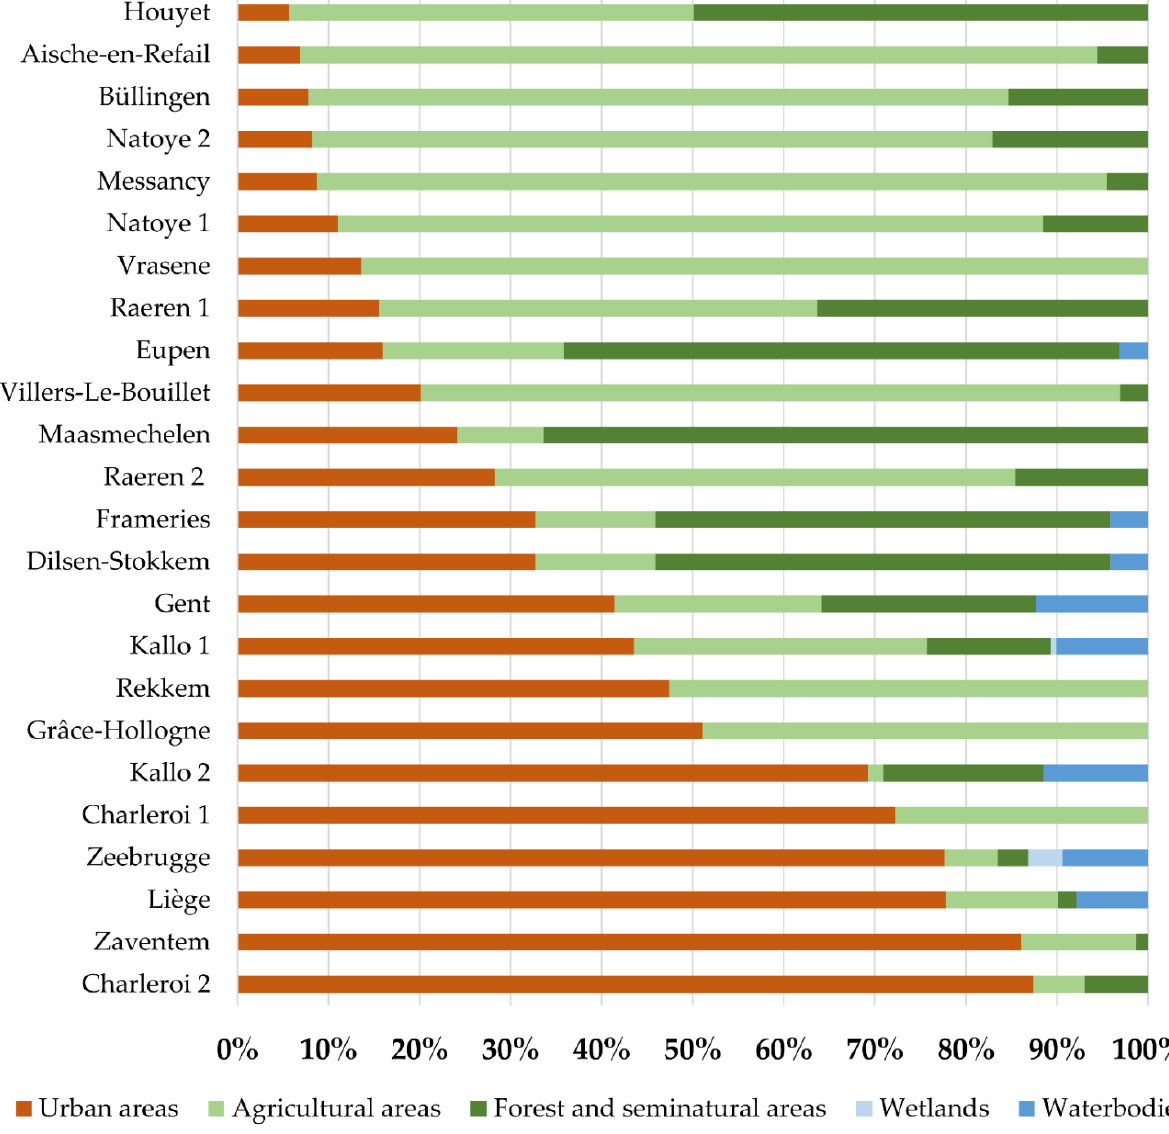
Figure 2. The percentage of main Corine Land-Cover classes in a 2.5 km buffer zone around the sampling locations (group levels based on five classes). Table 1. Pairwise F ST estimates between biotypes and biotype hybrids of Culex pipiens s.s. based on COI sequences, calculated using Arlequin v3.5. Hybrids = Cx. pipiens biotype molestus X Cx. pipiens biotype pipiens . Significant values after standard Bonferroni correction marked by an asterisk ( p <